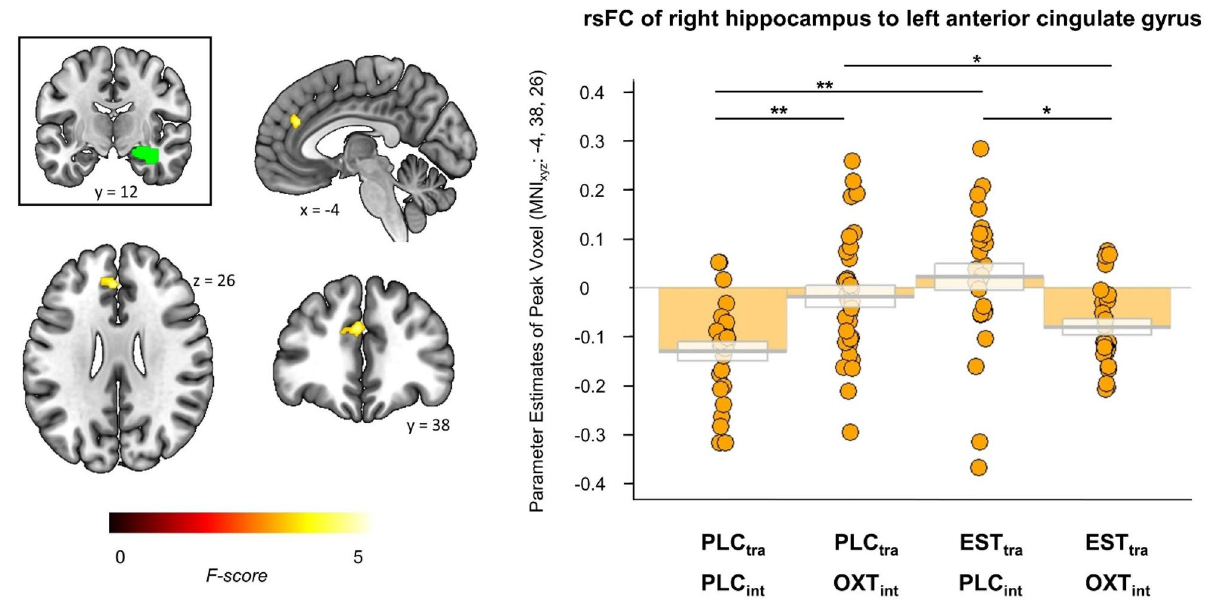
Figure 1. Treatment effects on the resting-state functional connectivity (rsFC) between the right hippocampus (green cluster) and the left anterior cingulate gyrus in women. The single treatment with either estradiol or oxytocin significantly increased rsFC between the right hippocampus and the left anterior cingulate gyrus. However, the combined treatment led to an rsFC between the right hippocampus and the left anterior cingulate gyrus comparable to that of the placebo group. Error bars indicate standard errors of the mean. PLC tra = transdermal placebo gel; PLC int = intranasal placebo; OXT int = intranasal oxytocin; EST tra = transdermal estradiol. * p < 0.05, ** p <